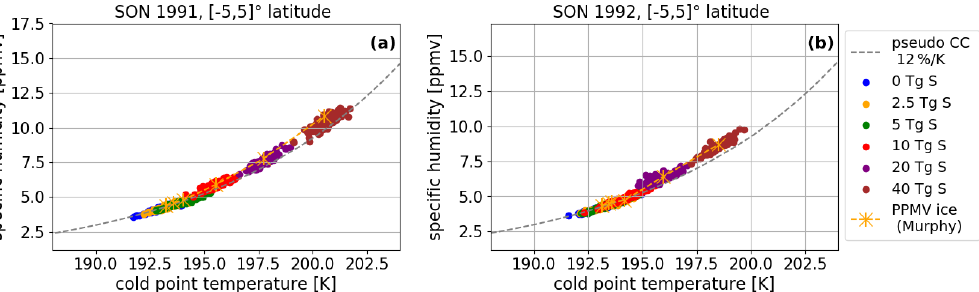
Figure 8. Seasonal averages of specific humidity at the cold point as a function of cold-point temperature for SON 1991 (a) and 1992 (b) . Values for each individual ensemble member are shown as dots for the inner tropics. An approximation (see text) for the Clausius–Clapeyron equation at this temperature range with an 12% increase of specific humidity per Kelvin is indicated by a dashed gray line. The exact solution for the Clausius–Clapeyron equation over ice by Murphy and Koop (2005) is calculated for the average ensemble cold-point temperatures and pressure and shown in